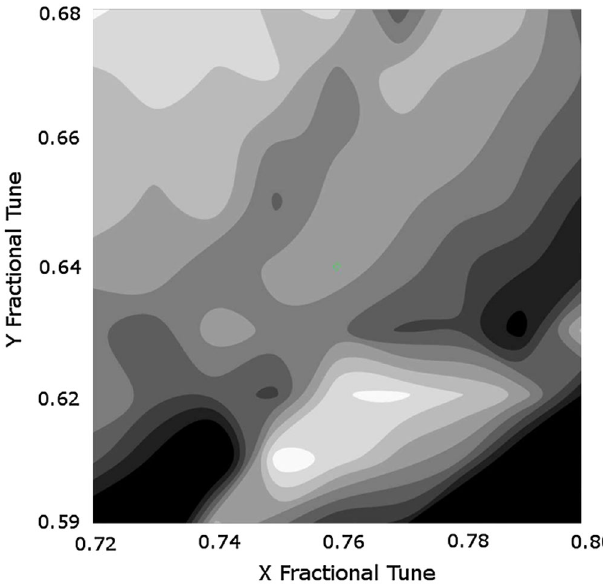
FIG. 9. A contour plot of the momentum compaction across the scanned tune space. Darker areas denote a smaller compac- tion factor. The range of values is between (cid:1) 0 : 0006 to 0.0005. The green e symbol represents the location of the ideal tunes.